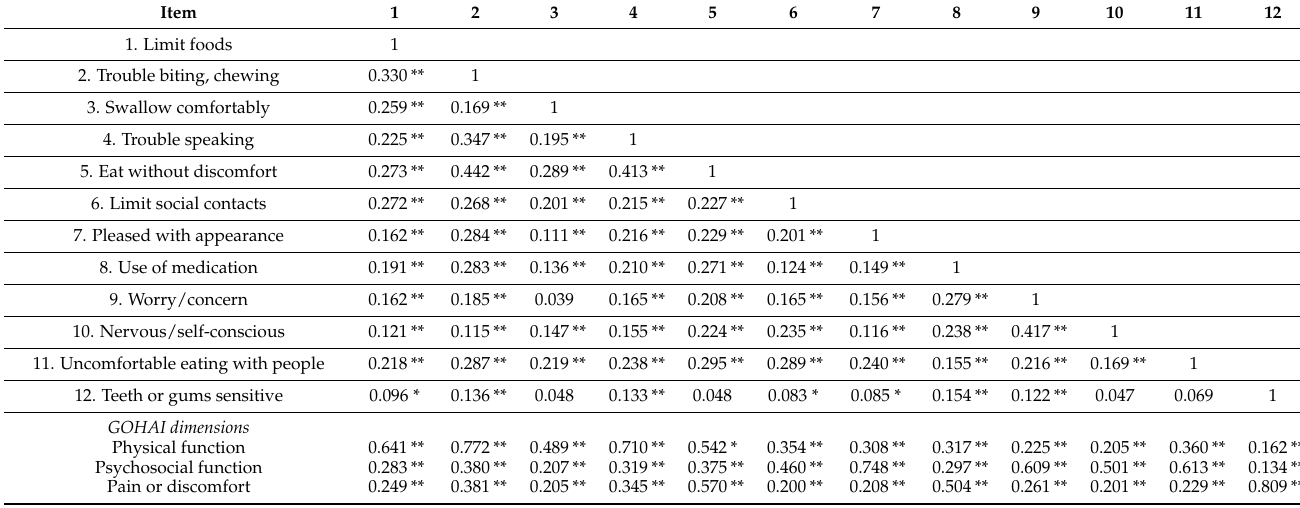
Table 2. Inter-item correlations for the GOHAI and item–GOHAI dimensions correlations (Pearson coefficient).